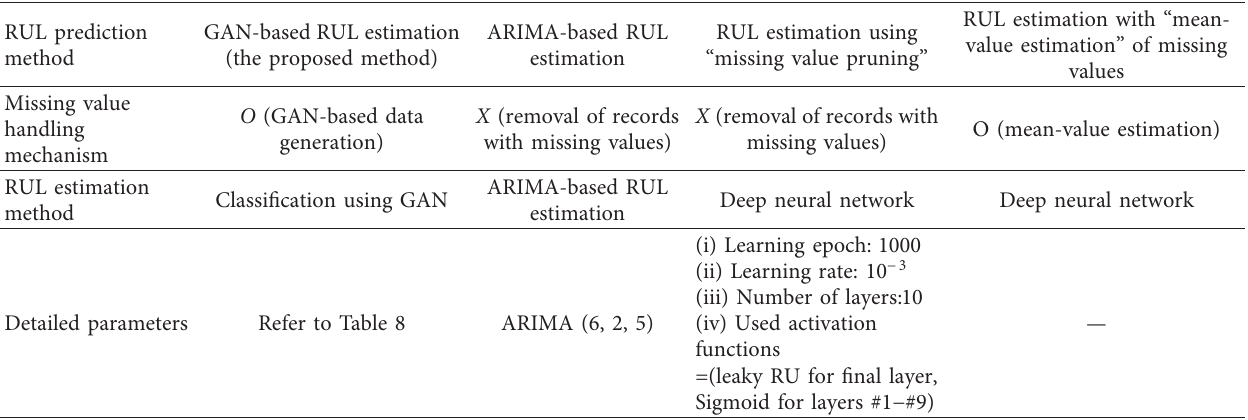
Table 7: Four RUL prediction methods.